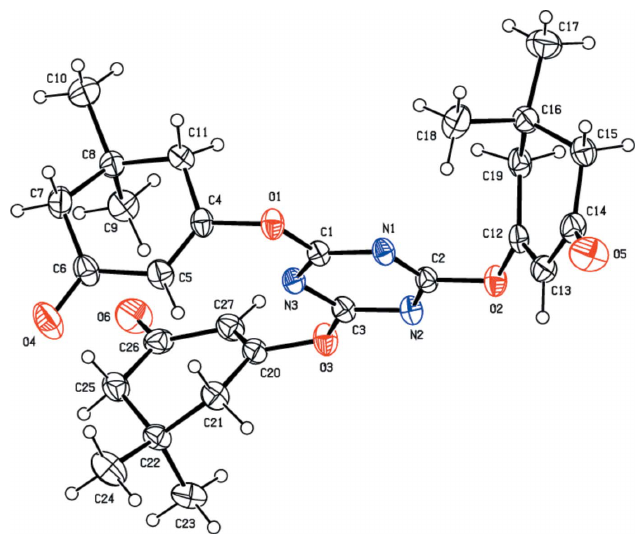
Figure 1 The molecular structure of the title compound. Displacement ellipsoids are drawn at the 30% probability level. H atoms are shown as spheres of arbitrary